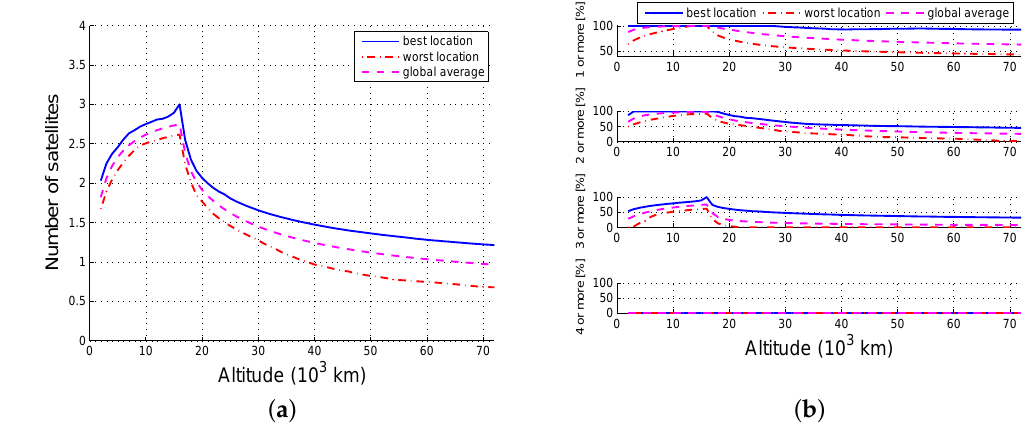
Figure 7. Availability as a function of altitude (1/8): ( a ) number and ( b ) probability.